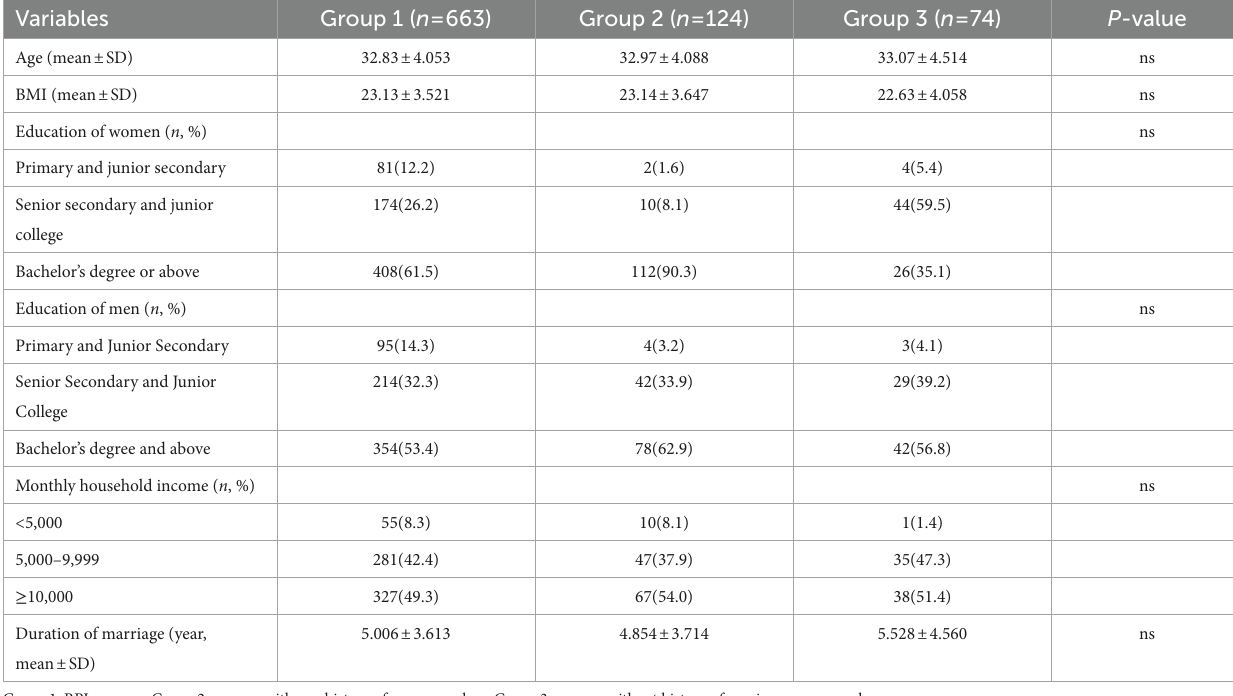
TABLE 1 Comparison of social characteristics and obstetric characteristics of